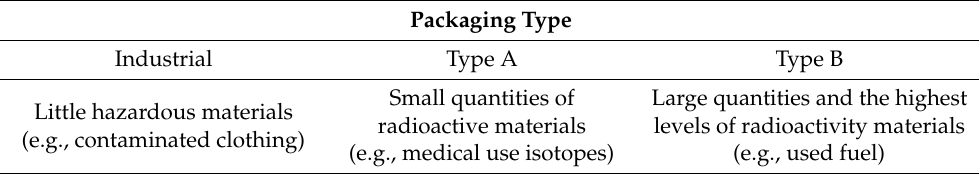
Table 6. Classification of packaging type for transportation of radioactive materials.